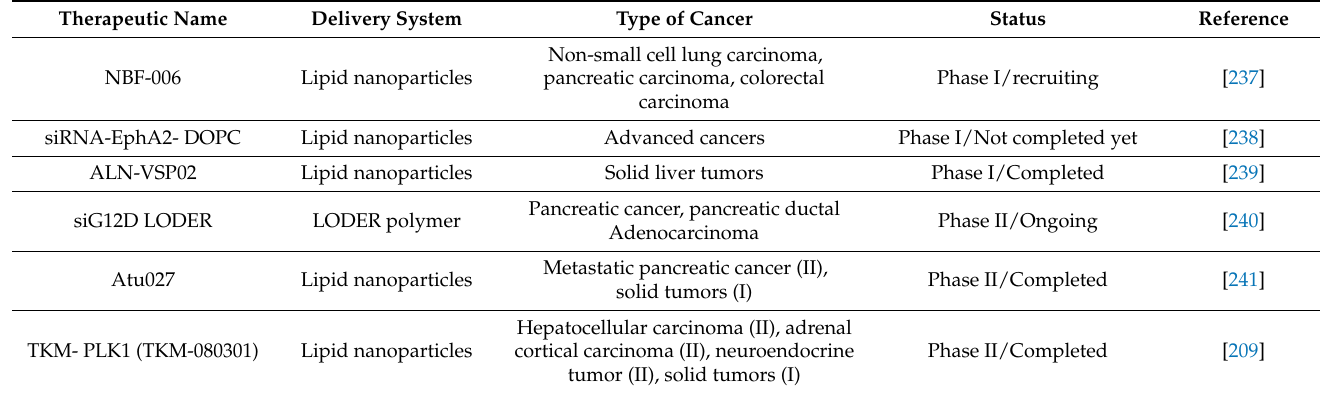
Table 5. Representative list of anticancer siRNA-mediated nanoparticles in clinical